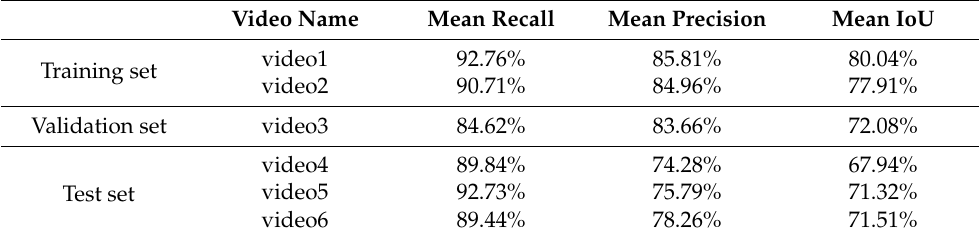
Table 2. Results of the rough detection network.